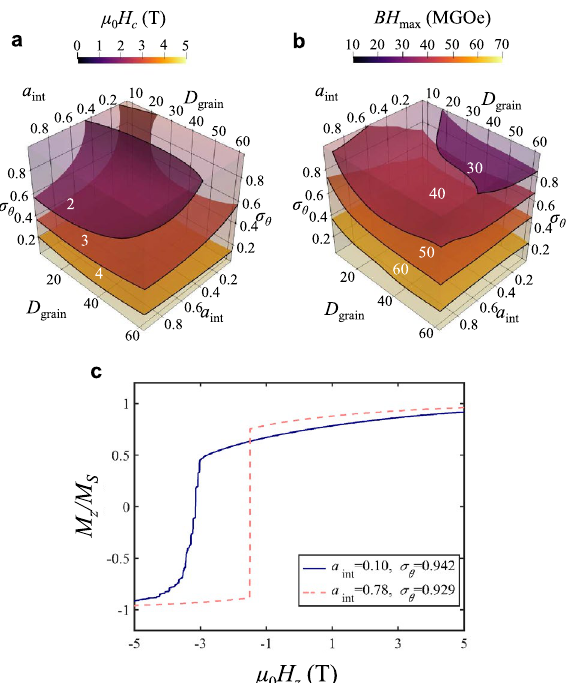
Figure 6. Dependences of coercivity and BH max on input parameters. Ensemble of (a) coercivities and (b) BH max values predicted from KRR, SVR and ANN models. The annotated numbers on the contour planes denote the values of coercivity and BH max in the units of T and MGOe, respectively. The contour plots were created with ParaView. (c) Demagnetization curves for different sets of indicated a int and σ θ